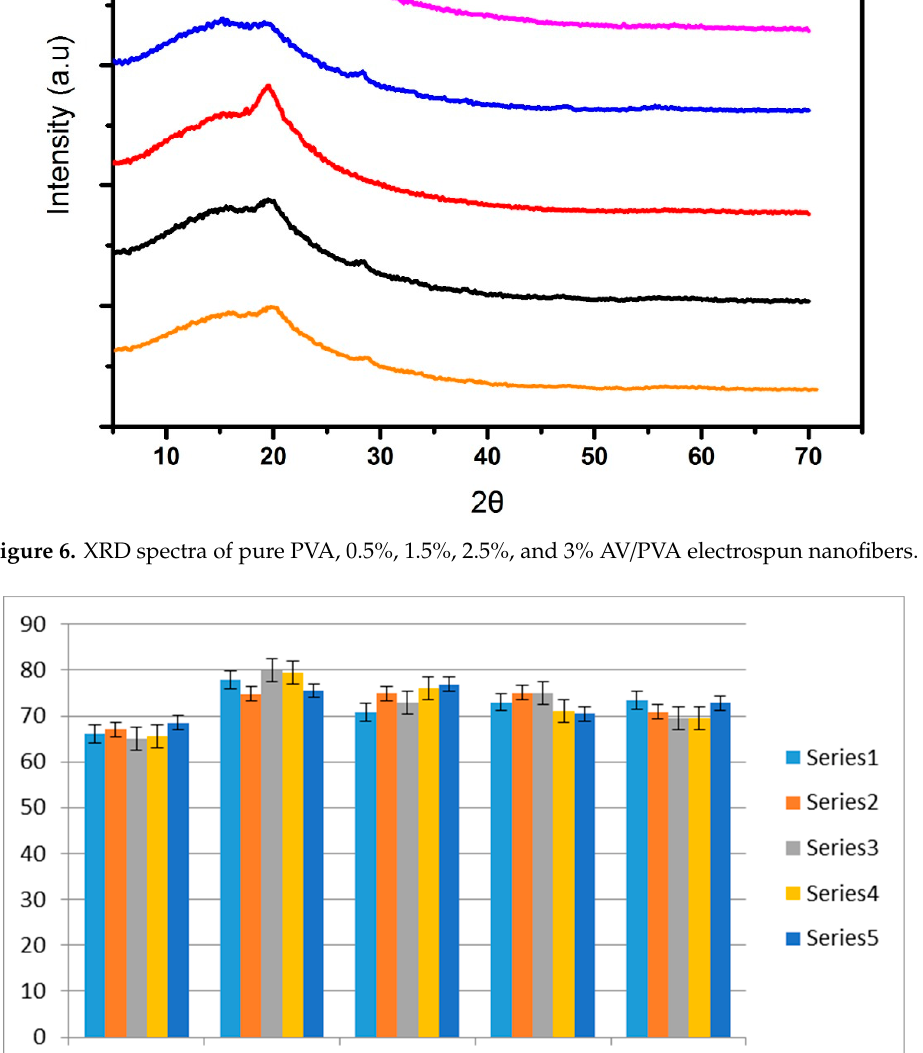
Figure 7. Hydrophilic behavior of all resultant samples.